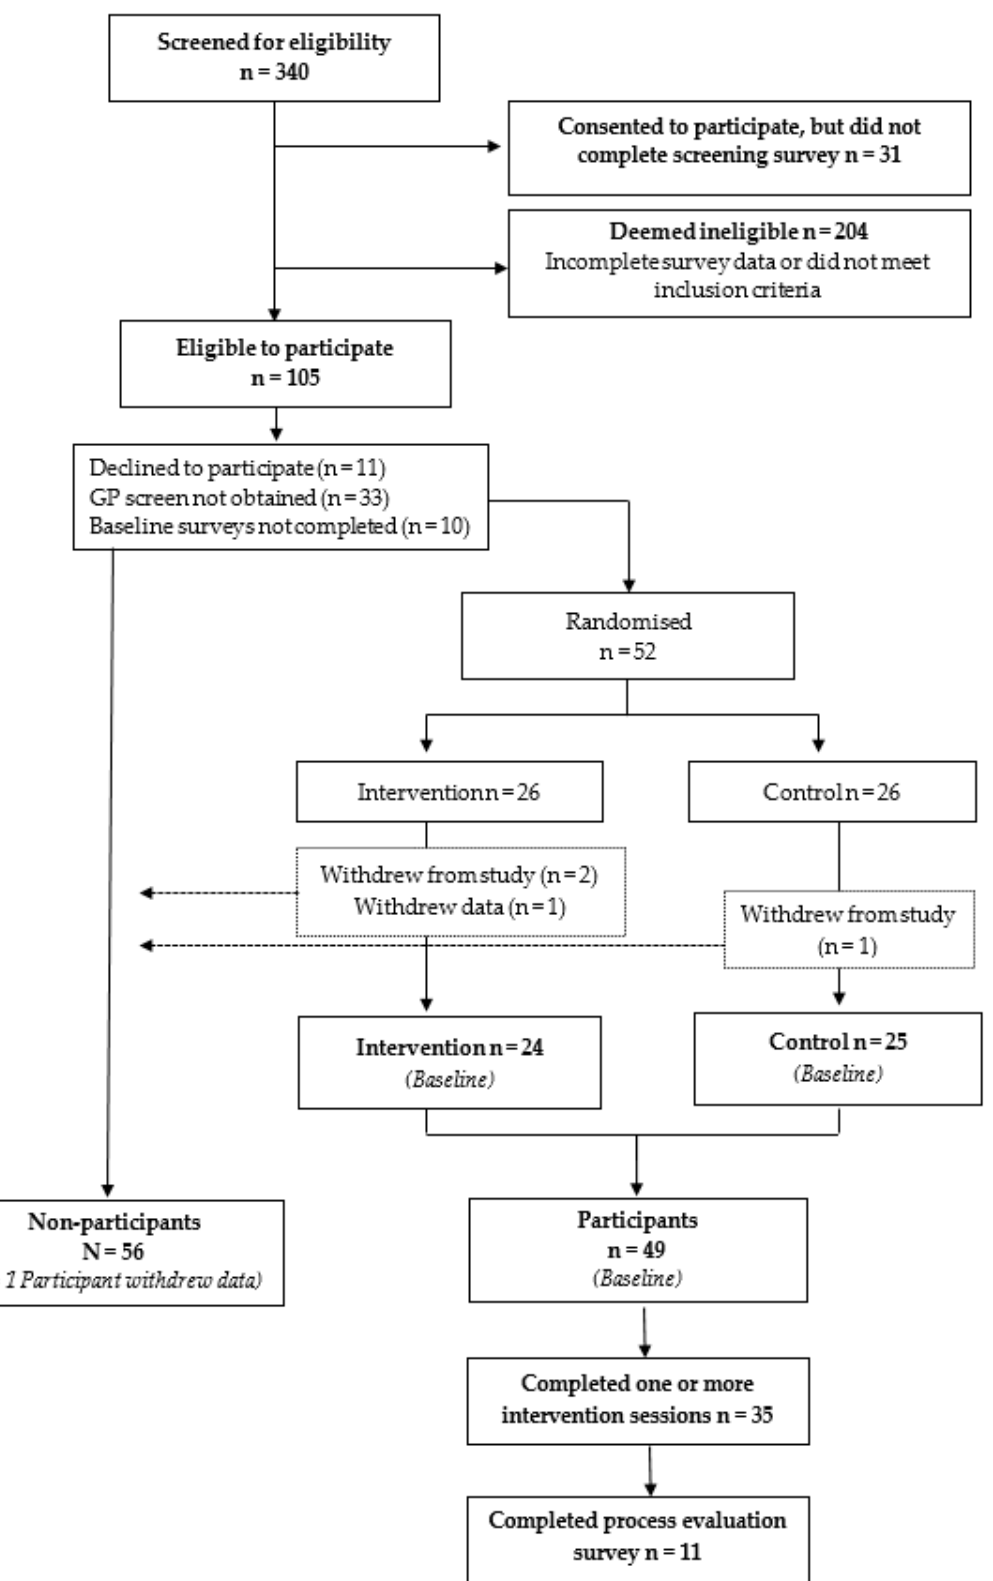
Figure 1. Study flow diagram of participants in the FoodFix intervention randomised controlled trial.